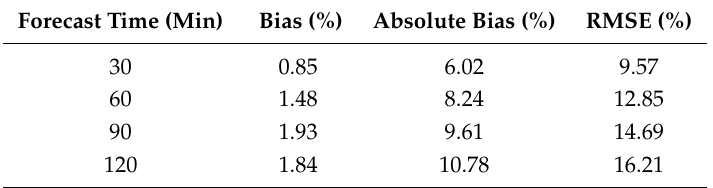
Table 4. Values of the bias, absolute bias and RMSE for the case of 4 October 2017. The basis for the calculation is the area of